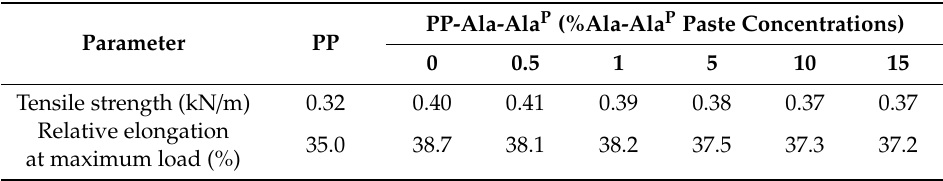
Table 7. Results of tensile strength